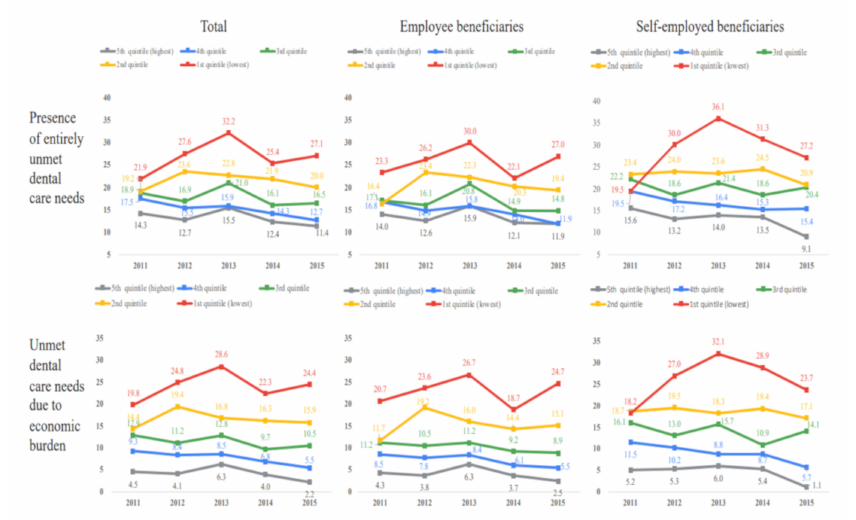
Figure 2. Entirely unmet dental care needs by income quintile group and the type of NHI